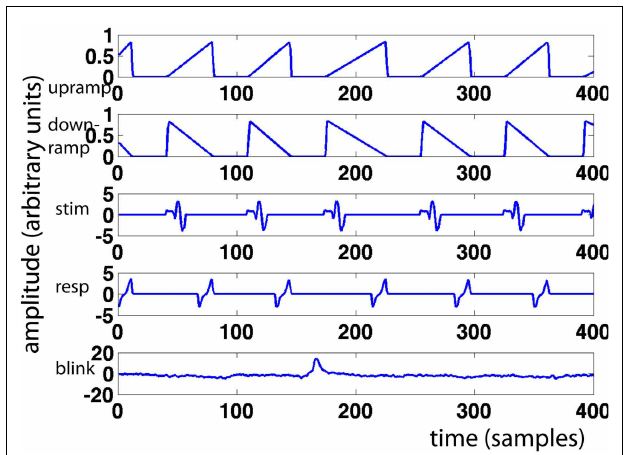
FIGURE 1 | Sample regressors. Pictured are, from top to bottom: upramp, downramp, stimulus regressor, response regressor, and eyeblink regressor. X -axis represents time in samples, y -axis regressor amplitude in arbitrary